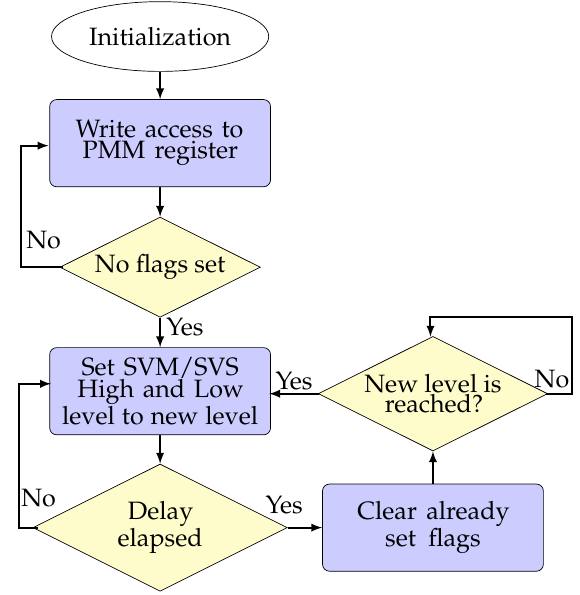
Figure 5. Setting PMM core level (Purple color: Action, yellow color: